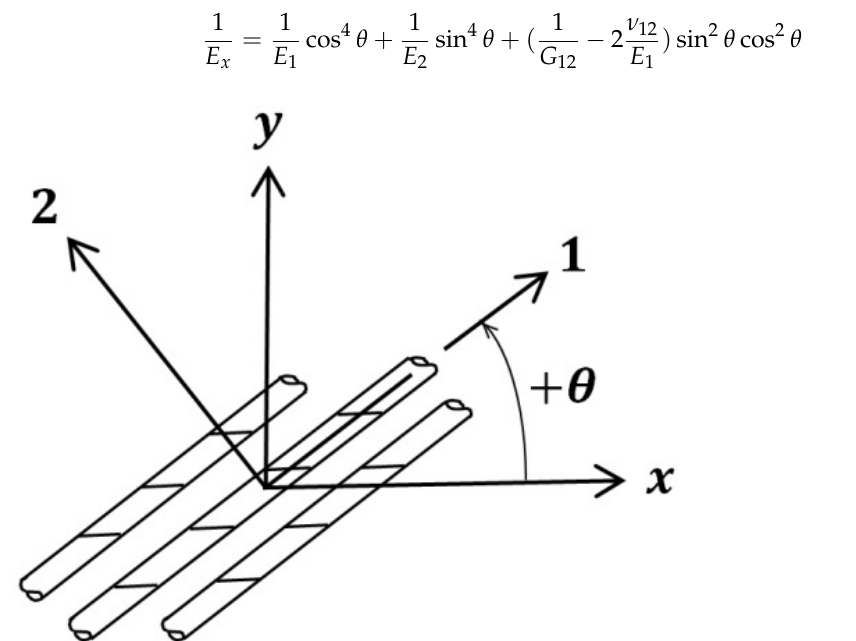
Figure 3. Illustration of principal axes (1, 2) and general axes (x-hoop, y-longitudinal) of a unidirec- tional FRP layer.